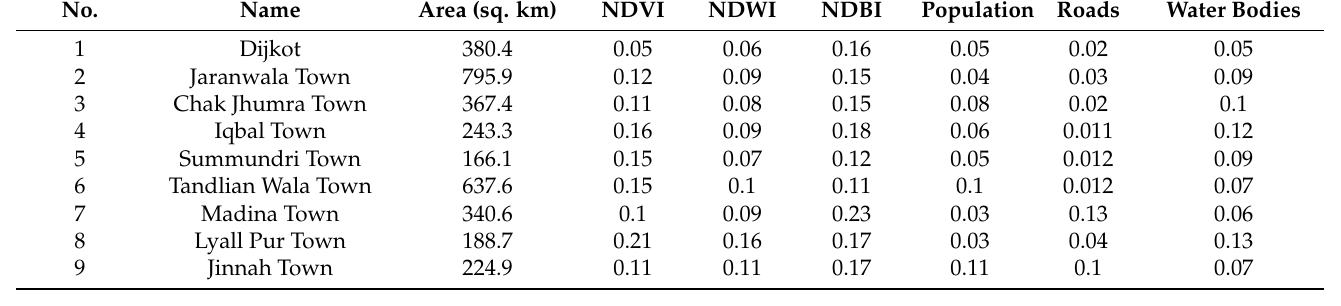
Table 3. Standard deviation values of the indices and factors.